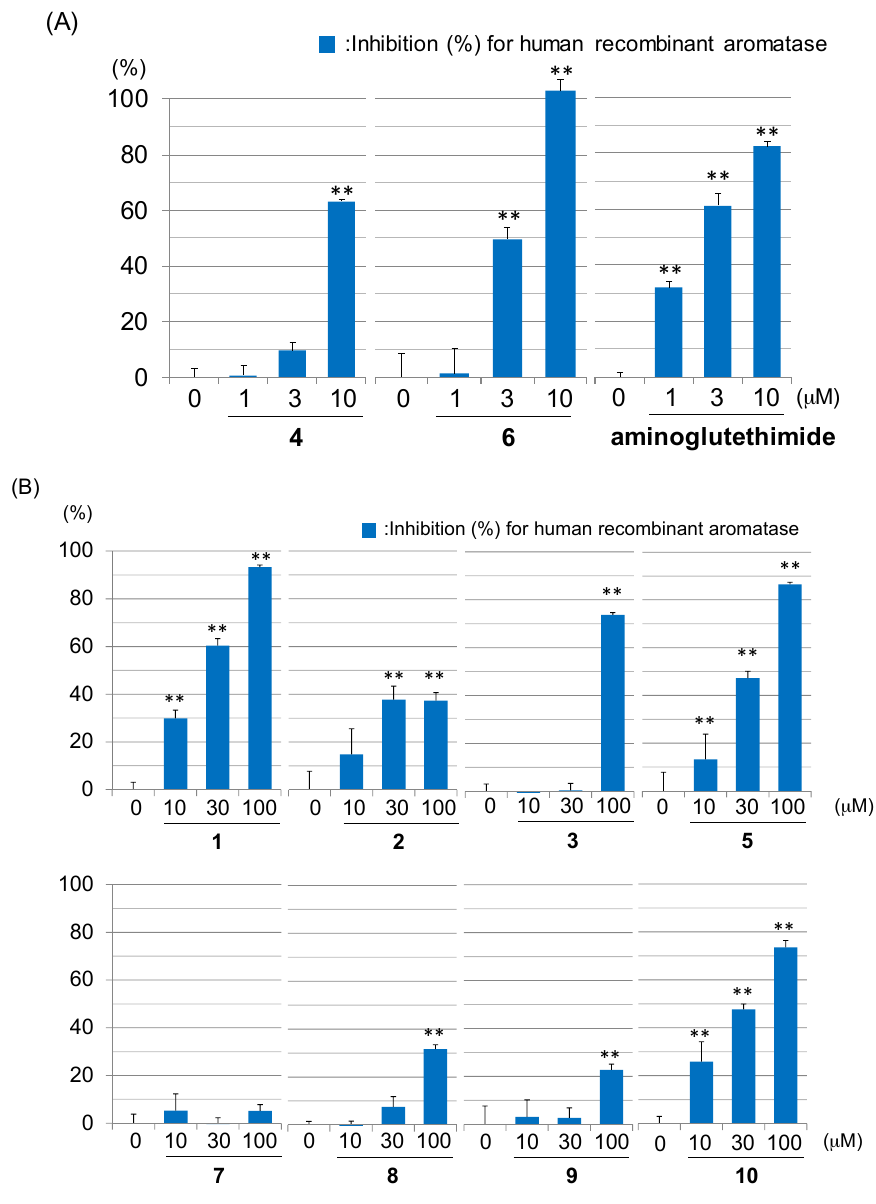
Figure 4. Inhibitory effects of sterols ( 1 – 10 ) from P. eryngii against human recombinant aromatase. ( A ) Inhibitory effects of sterols ( 4 , 6 ) and aminoglutethimide at 1, 3, and 10 µM. ( B ) Inhibitory effects of sterols ( 1 – 3 , 5 , 7 – 10 ) at 10, 30, and 100 µM. Each value represents the mean ± the standard error (S.E.) of three determinations. Significant differences from the vehicle control (0 µM) group shown as **: p < 0.01.